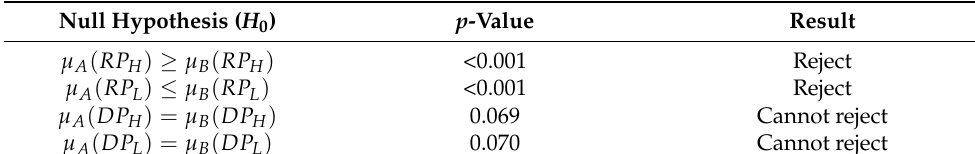
Table 4. Statistical test results for Scenario A and Scenario B prices.